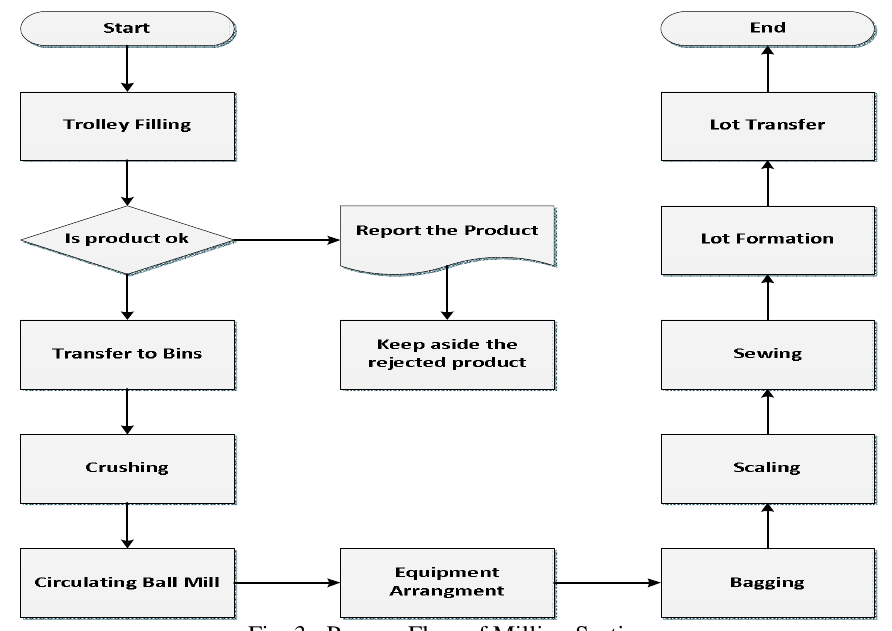
Fig. 3: Process Flow of Milling